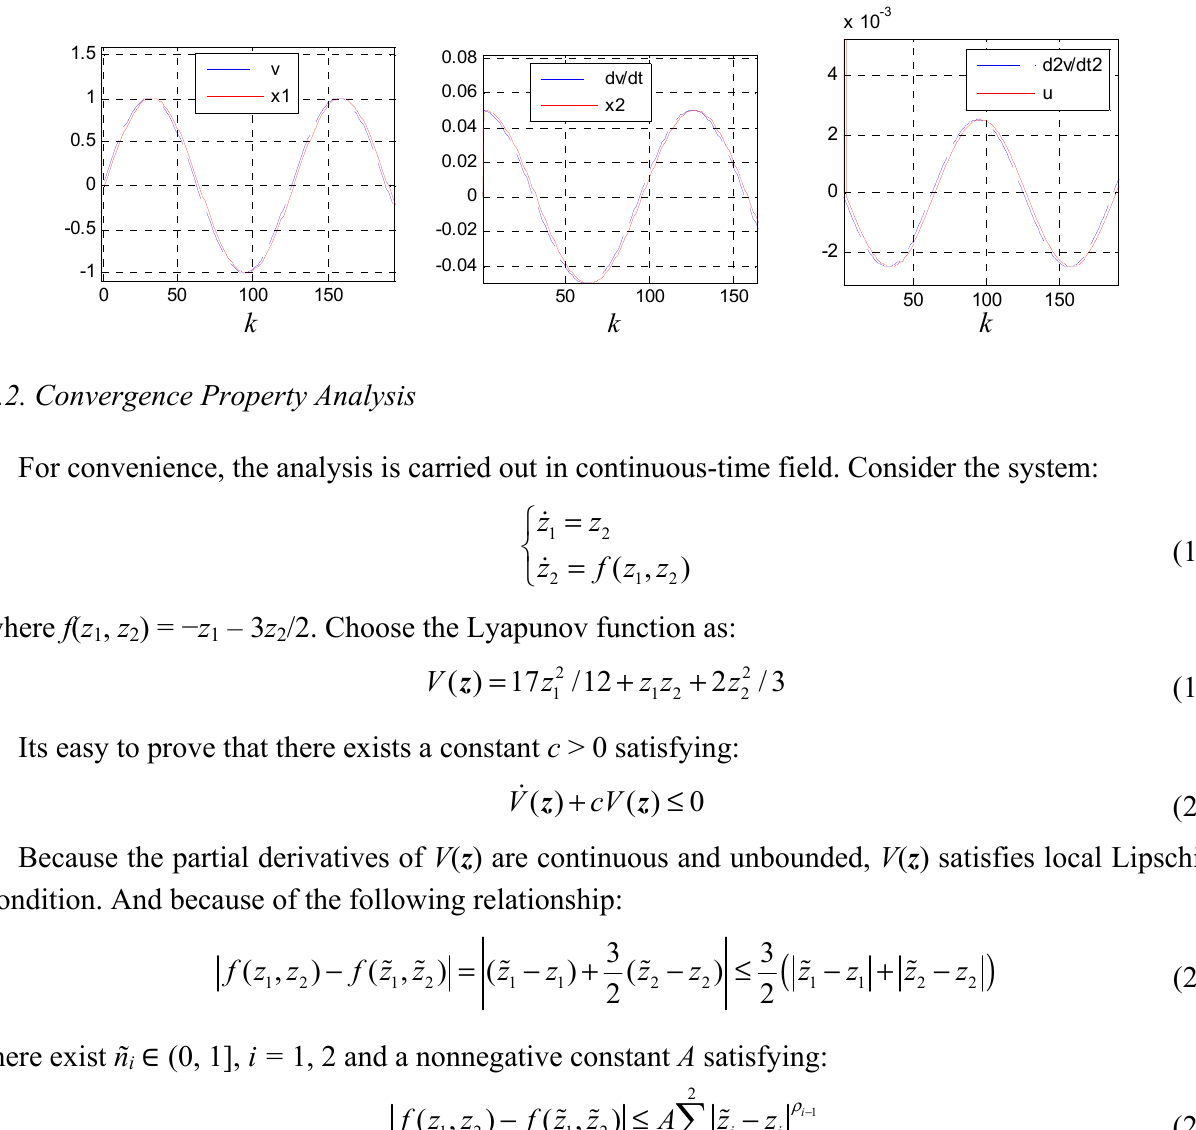
Figure 9. The tracking and differentiating performances of the TD